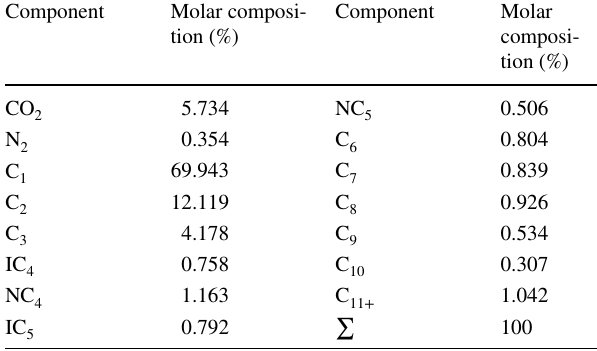
Table 1 Tested components and compositions of condensate gas Component Molar composi- tion (%)